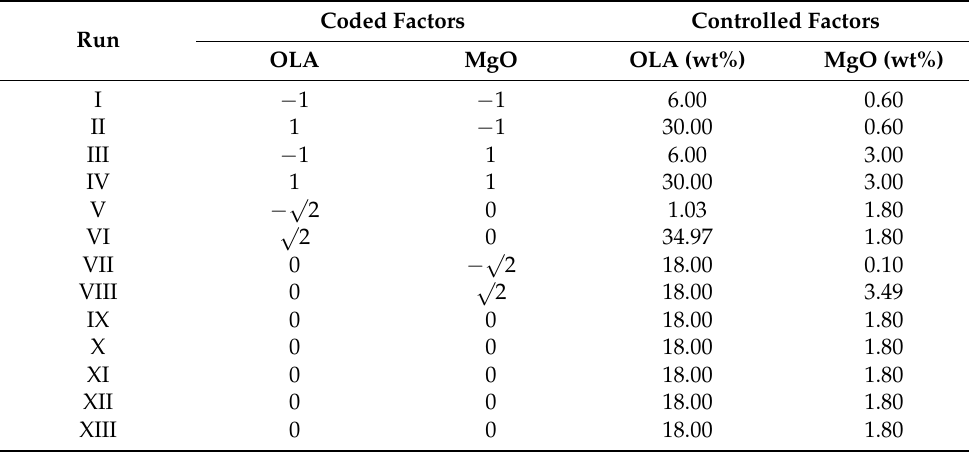
Table 1. Worksheet for the Box–Wilson experimental design used. Coded Run